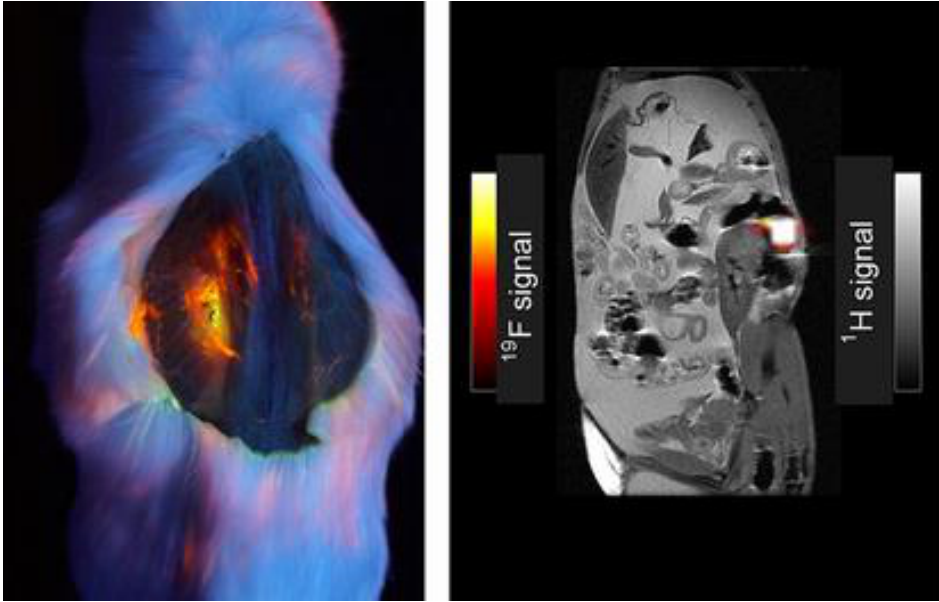
Figure 6. Dual fluorescence and 19 F MRI, dye 26 (100 µL of 100 mM in DCM). Image under black-light excited at 365 nm of mouse post-mortem ( left ); grayscale image ( right ) demonstrating overlay of 1 H and 19 FMRI. Figure used with permission from [38]. Copyright 2016 John Wiley & Sons.